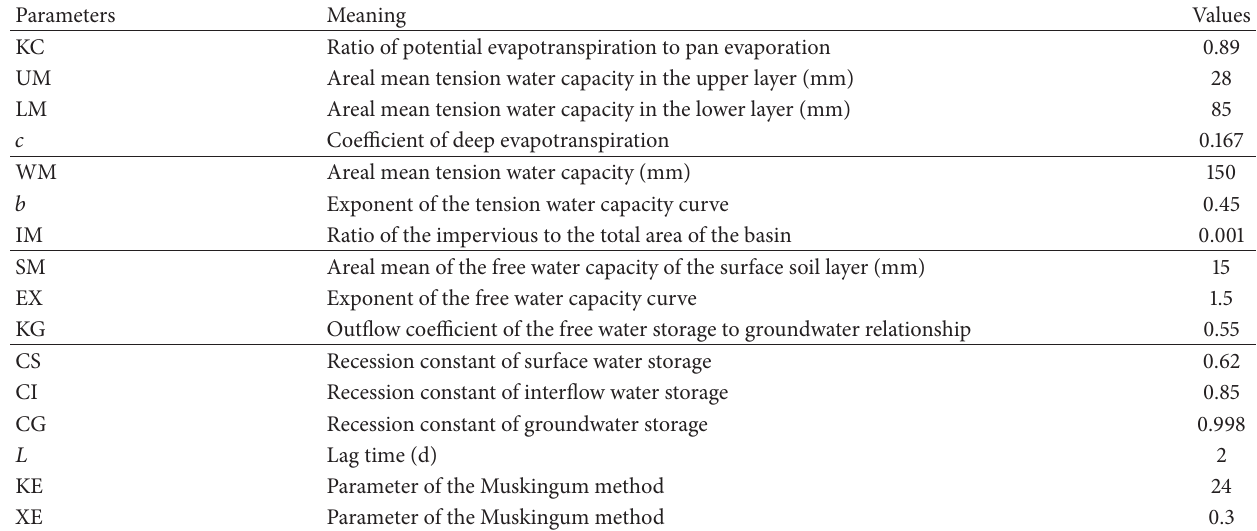
Table 1: Calibrated parameters for the daily Xinanjiang model in upper Huaihe River above the Xixian station. Parameters